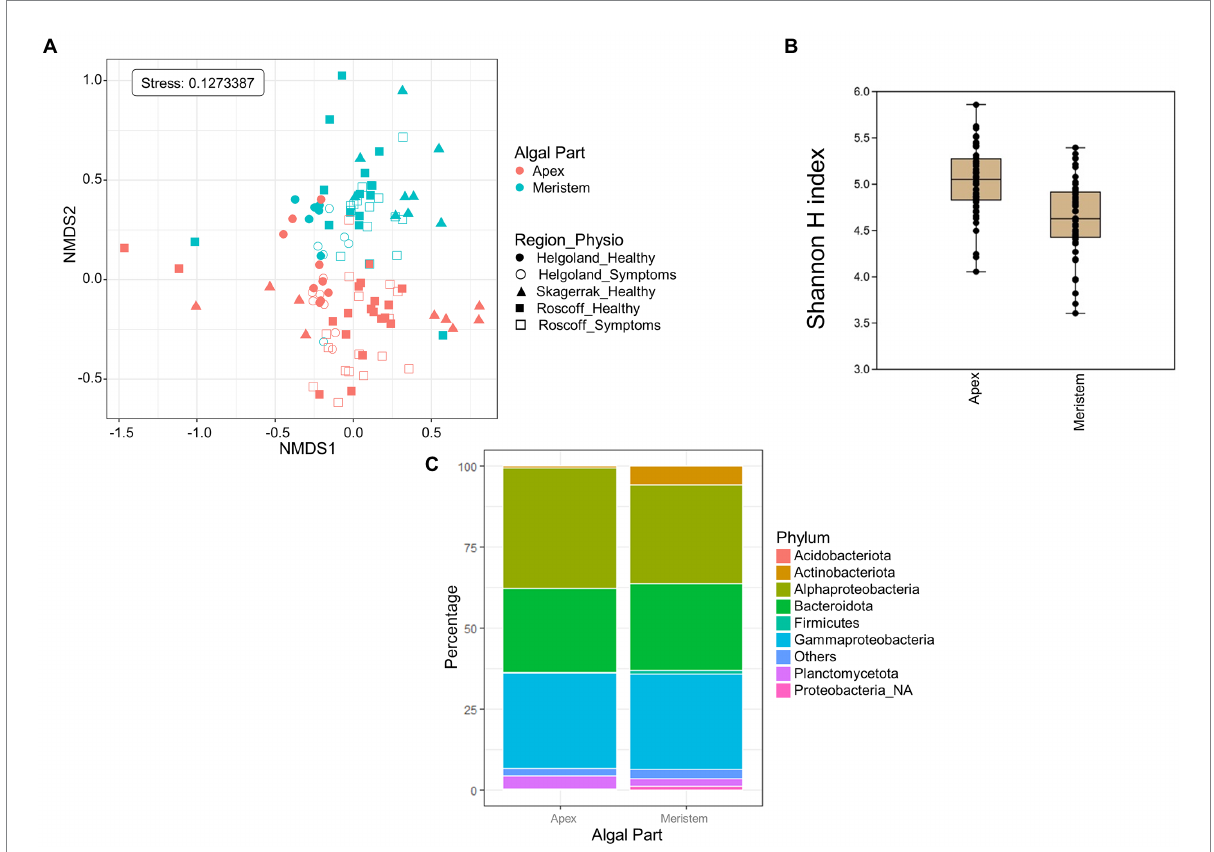
FIGURE 2 Algal blade part analysis. (A) NMDS analysis of the microbiome composition. Results show a clear separation of the apex and meristem samples (PERMANOVA, p = 0.001). (B) Box plot of alpha-diversity (Shannon H index) across different sample types calculated at the ASV level. Error bars correspond to the range; n = 111; mean alpha-diversity differs significantly between conditions ( t -test, t = 5.47, p < 0.0001; C) Comparison of microbiome composition between apex and meristem samples at the phylum level. Bars show the relative abundance of 16S rRNA gene metabarcoding sequences; all phyla were detected in all sample types, and only their relative abundance varied. Proteobacteria_NA : unclassified as Proteobacteria